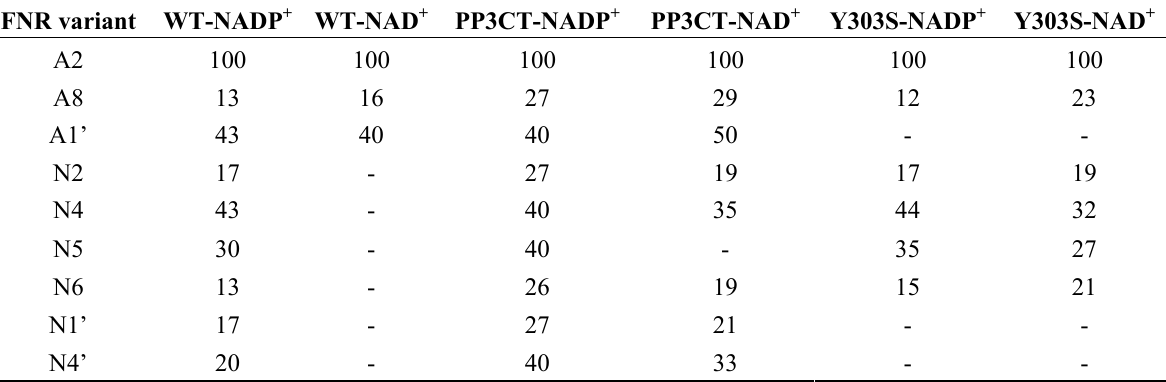
Table 2. STD relative values at 2 s saturation time for Saturation Transfer Experiments, normalized (100%) against the larger absolute STD fractional value for each ligand, performed for the complexes between WT, PP3CT and Y303S Anabaena FNR variants with NADP + and NAD +